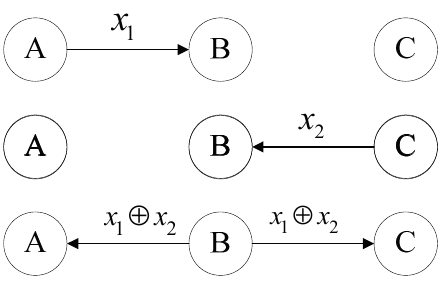
Figure 1. A network coding